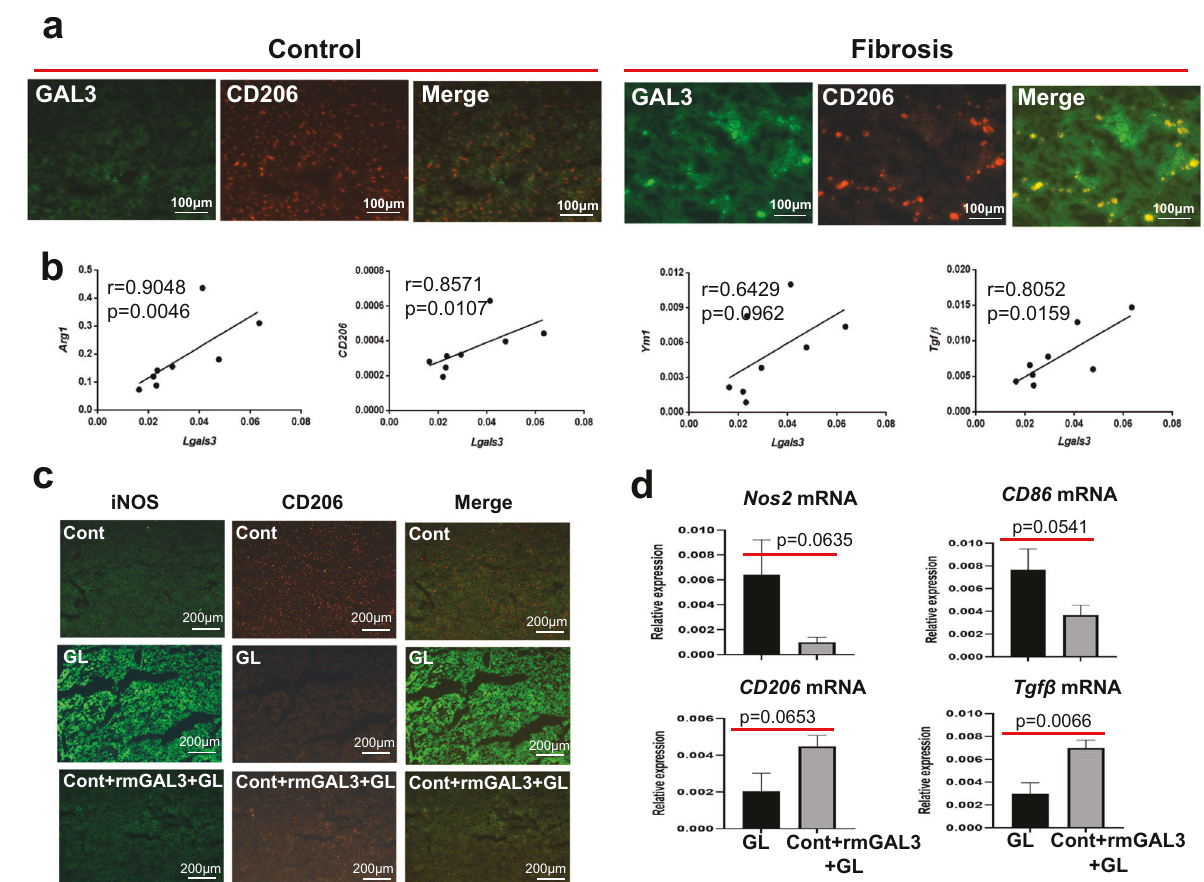
Fig. 3 GAL3 expression is closely correlated with M2-like macrophage activation. a The colocalisation of GAL3 and CD206 in the fi brotic liver. b The correlation between Lgals3 and M2-like macrophage activation markers, including Arg1 , CD206 , Ym1 and Tgf β . c The expression of the M1 marker iNOS and the M2 marker CD206 in the livers of acutely injured mice with or without recombinant GAL3 pretreatment. d The expression of the M1 markers ( Nos2 and CD86 ) and the M2 markers ( CD206 and Tgf β ) in the livers of fi brotic mice upon insult with or without GAL3 depletion ( n = 4 – 7). Group comparisons were performed using the Mann – Whitney U test or Student ’ s t